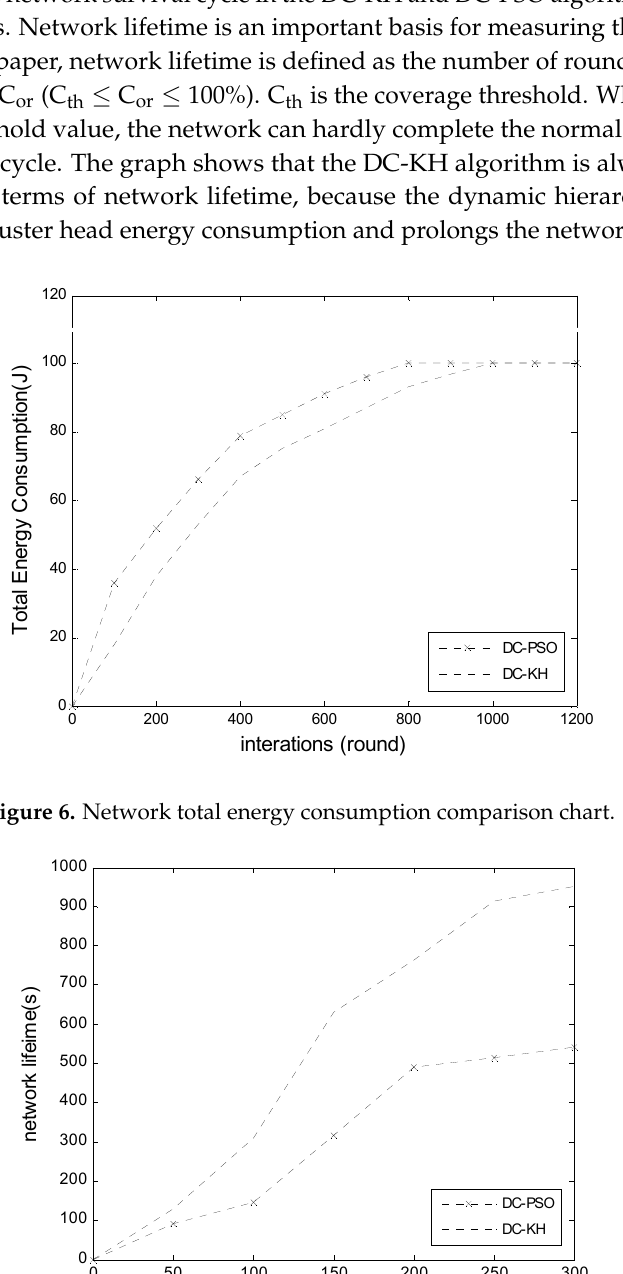
Figure 7. Network life cycle comparison chart.